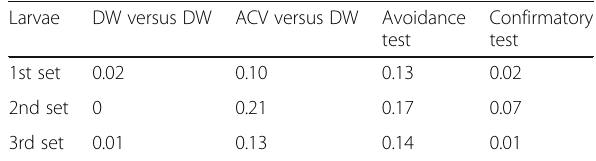
Table 6 Olfactory Response Index (ORI) for